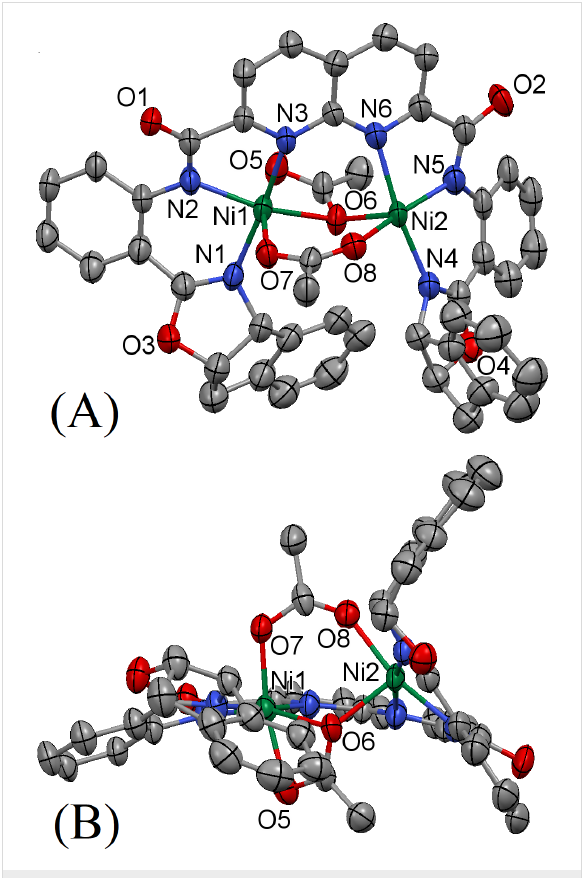
Figure 3: Thermal ellipsoid plot (50% probability) of the molecular structure of 16 ·Ni 2 (OAc) 2 . Hydrogen and solvate atoms have been omitted for clarity: (A) view normal to the mean molecular plane; (B) side view nearly perpendicular to (A) to allow better view of the region of open access to the metal site. The complex 16 ·Ni 2 (OAc) 2 crystallizes in the orthorhombic space group P 2 1 2 1 2 1 with a = 14.1829(5) Å, b = 14.8645(6) Å, c = 25.2342(10) Å, α = 90°, β = 90°, γ = 90°, V = 5319.9(4) Å 3 , Z = 4, D c = 1.450 mg m − 3 and μ (Mo K α ) = 1.017 mm − 1